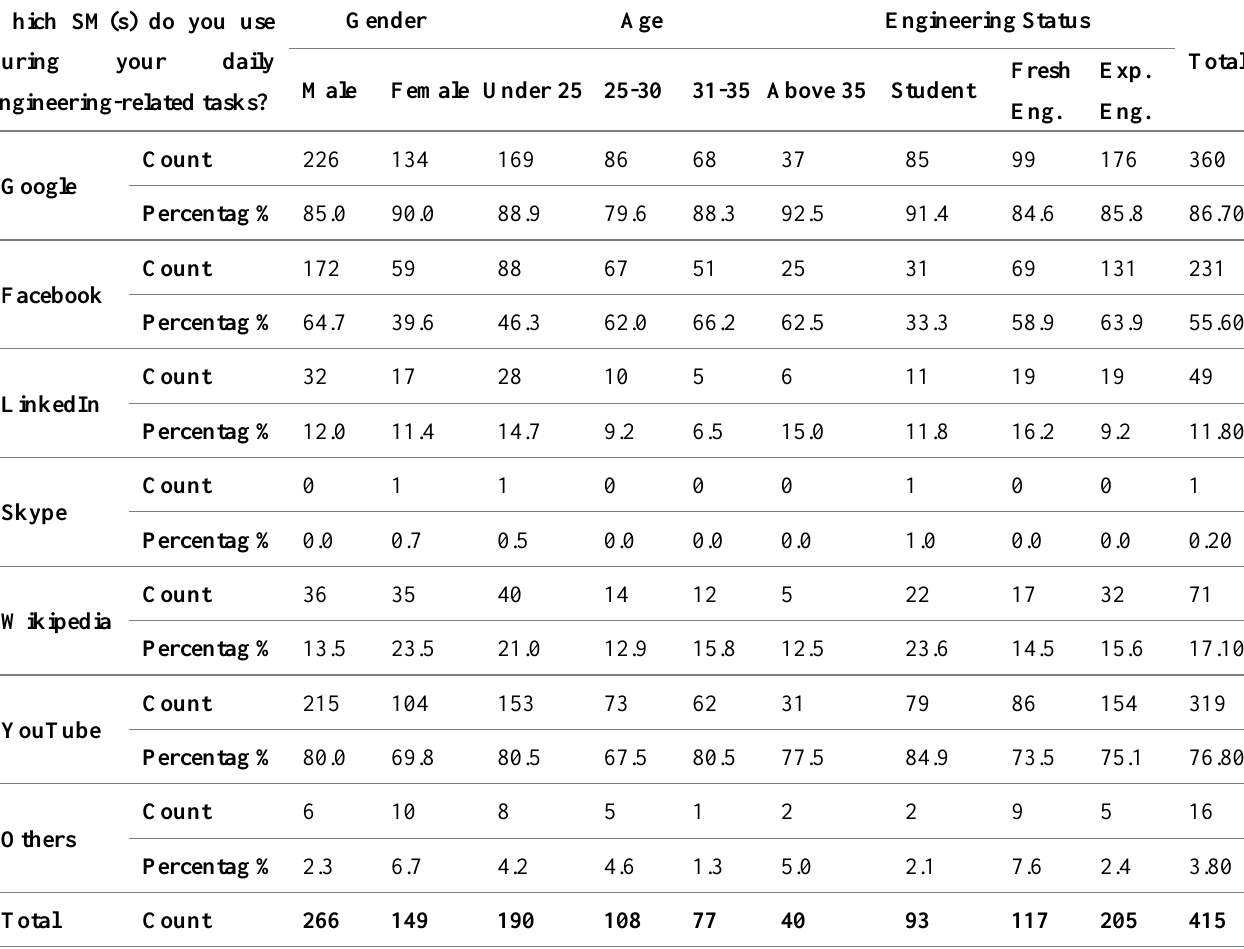
Table 3. Common SM used by Engineers Which SM(s) do you use